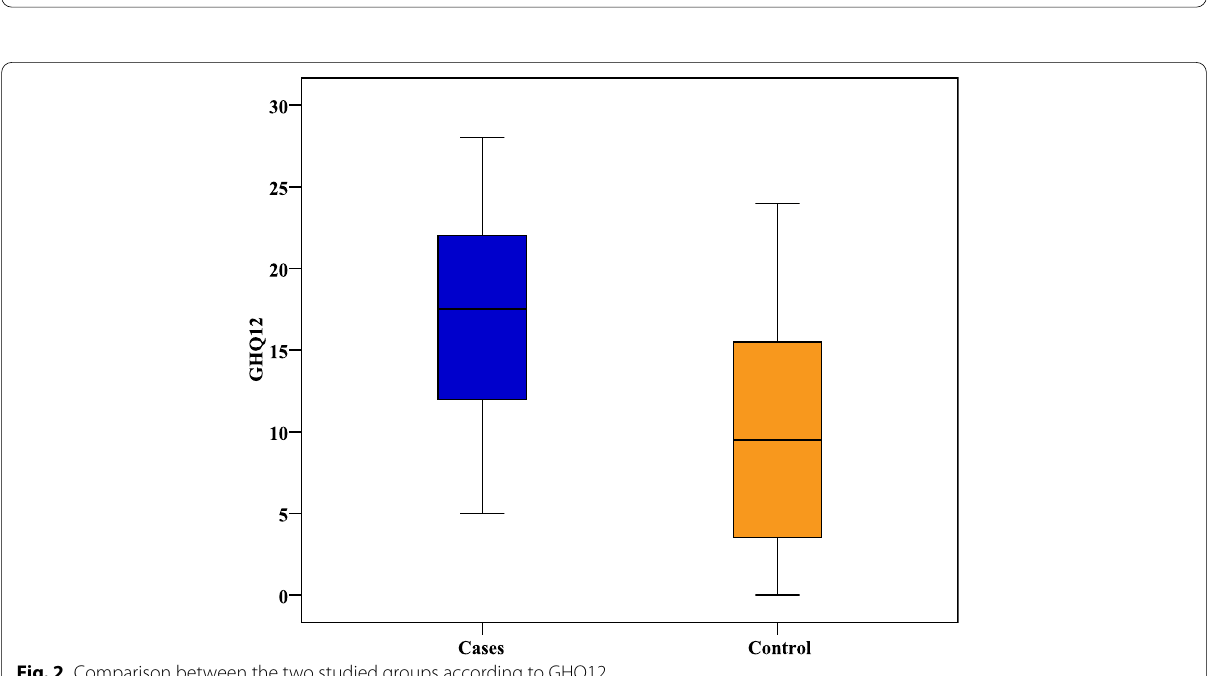
Fig. 1 Comparison between the two studied groups according to BDI-II